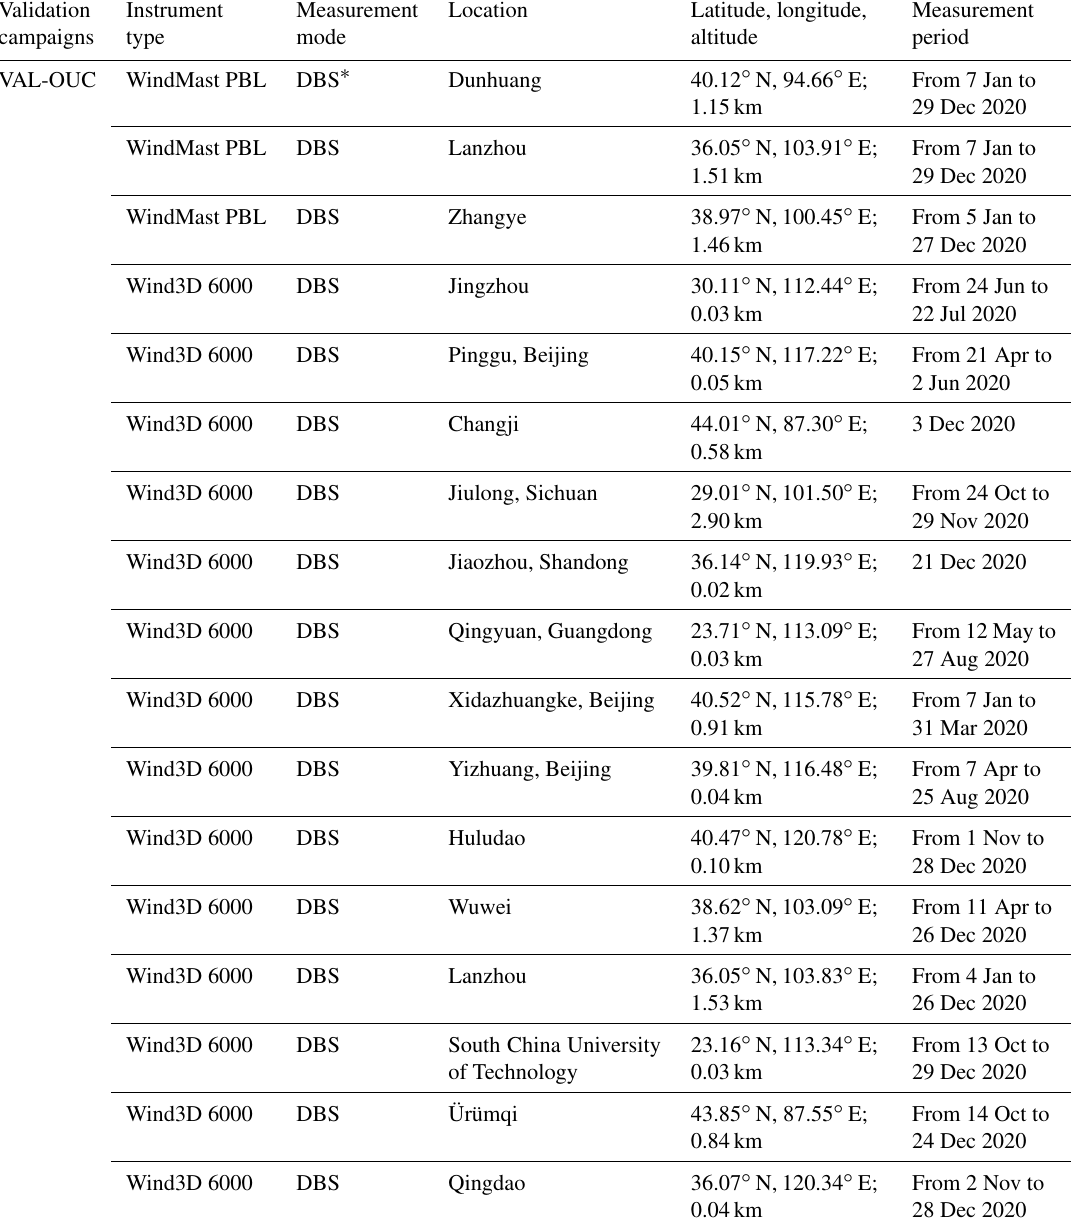
Table 1. Overview of Aeolus validation campaigns performed by the